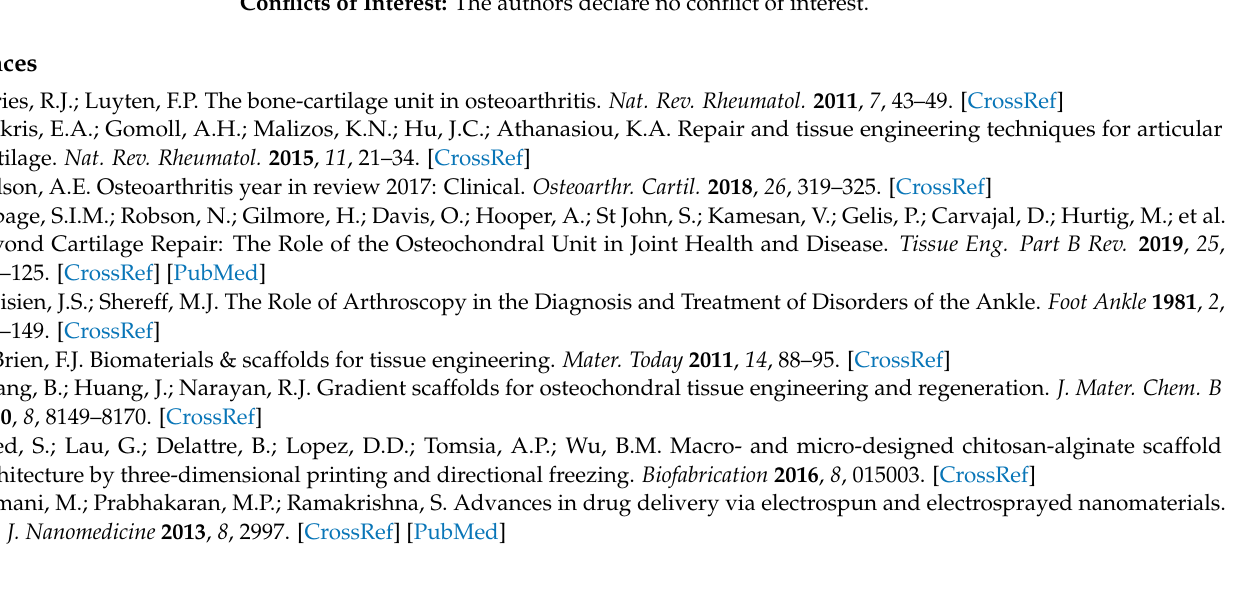
DMF; Figure S2: Calibration curve for KGN in PBS; Figure S3: SEM images of blank (a) PLGA; (b) PLGA/PEG 30% w / w ; and (c) PLGA/PVP 30% w / w particles, with no drug loading; Table S1. Pa- rameters used in the optimized electrospraying processes; Table S2. Composition, encapsulation efficiency and drug loading of the KGN-containing particles (n =